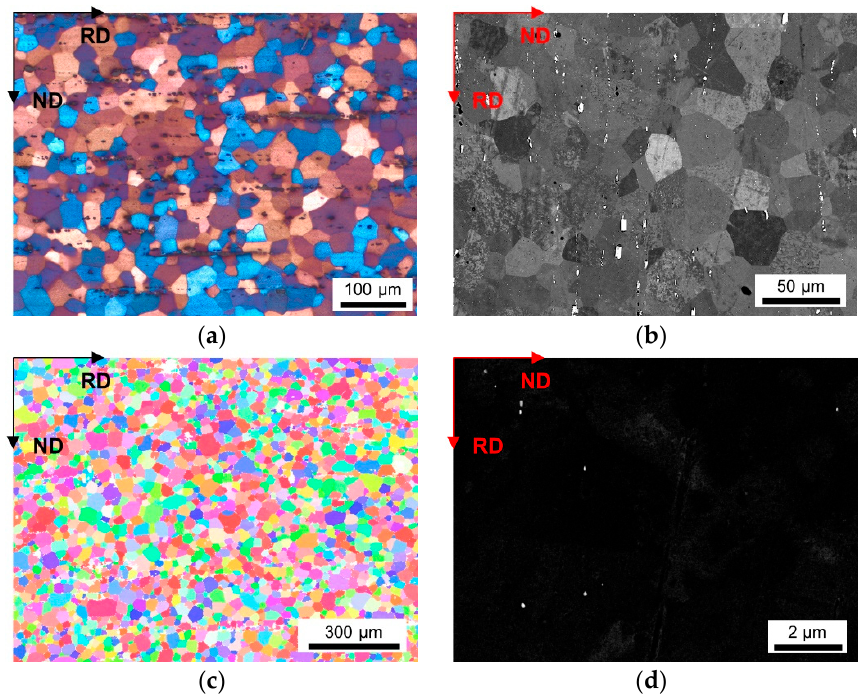
Figure A20. Microstructure of the soft annealed HFe-LMn cast under S-C conditions, homogenized at 550 °C and cold rolled to a CRD of 35%. ( a ) LOM. ( b ) BSE image. ( c ) EBSD IPF map in RD–ND plane. ( d ) BSE micrograph showing dispersoids.